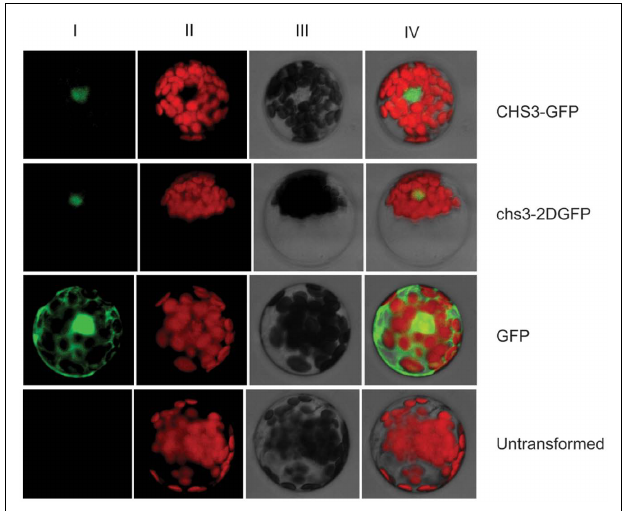
FIGURE 4 | CHS3-GFP and chs3-2D-GFP localize to the nucleus. CHS3-GFP and chs3-2D-GFP fluorescence as observed by confocal microscopy in Arabidopsis mesophyll protoplast cells (I: GFP, II: Autofluorescence, III: Bright field, IV: Merged). Experiments were repeated with multiple cells for each construct.